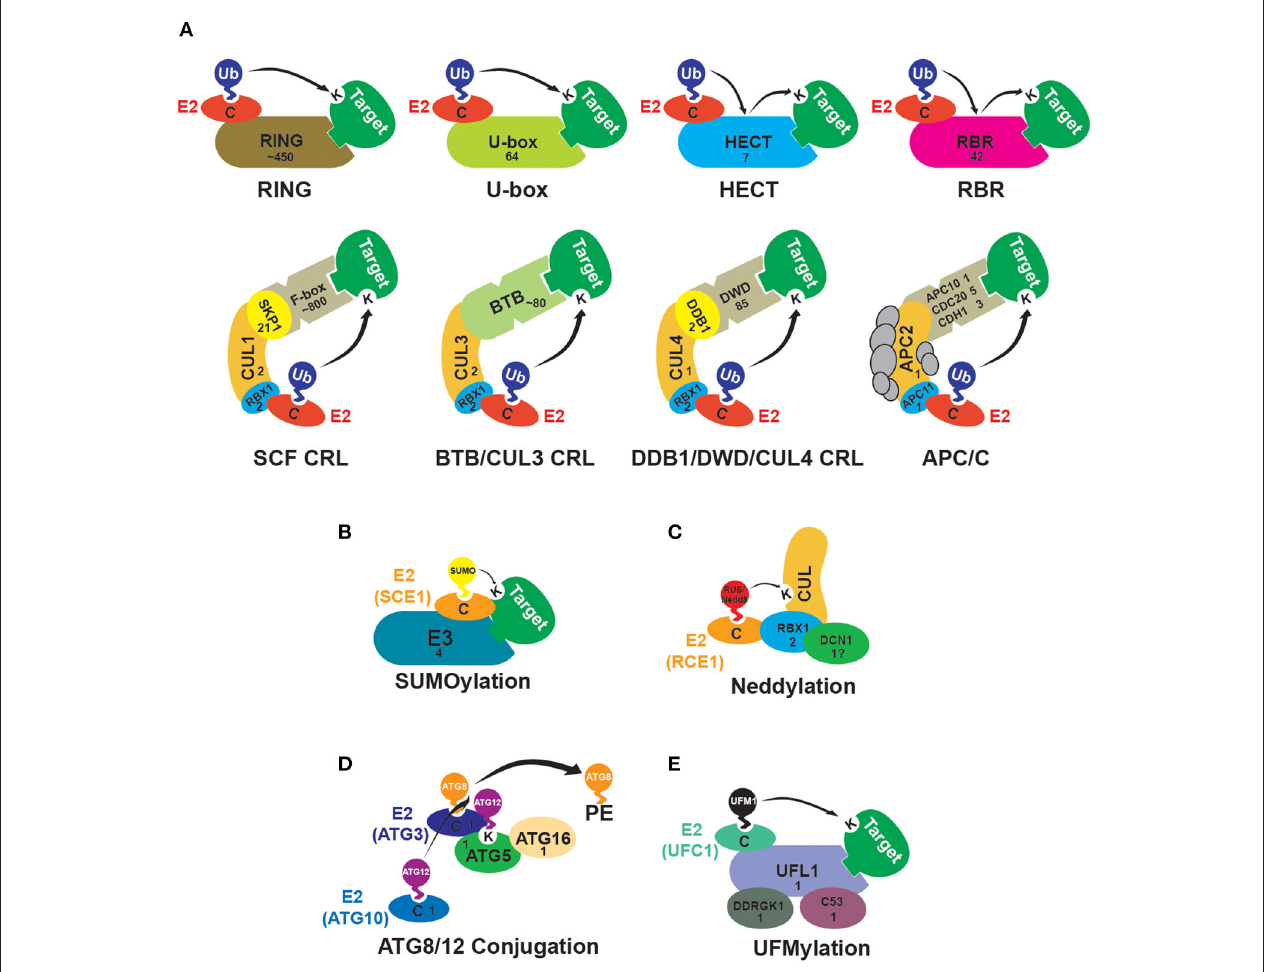
FIGURE 1 | Subunit composition of E3-ligases in plants. The numbers displayed within each subunit indicate the number of genes in the Arabidopsis thaliana genome putatively encoding the E3 ligase or E3 ligase component. (A) Schematics of E3 ubiquitin (Ub)-ligases in plants. RING ( R eally- I nteresting N ew G ene) and U-box E3 ligases bind an E2 and the target and facilitate direct transfer of Ub to the target protein. HECT ( H omologous to the E 6AP C arboxyl T erminus) and RBR ( R ING-in- B etween- R ING) E3 ligases transfer the Ub from the E2 to a cysteine residue in the E3, then from the cysteine to the target protein. The CRLs ( C ullin- R ING L igases) are multi-subunit structures with a Cullin (CUL) backbone protein that binds the E2 and a target adapter protein/complex. In SCF ( S kp1/ C UL1/ F -box) complexes target adaptor F-box proteins bind to an Skp1 ( S -phase K inase-associated P rotein 1)-like protein which interacts with CUL1. In the CRL3 complexes, a BTB ( B road-Complex, T ramtrack, and B ric-à-Brac) domain-containing protein binds to the target and CUL3. In the CRL4 complexes, WD40 domain-containing DWD ( D DB1 Binding WD 40) proteins bind the targets and interact with CUL4 through a DDB1 ( D amaged D NA B inding 1) protein bridge. The APC/C ( A naphase- P romoting C omplex/ C yclosome) contains at least 11 subunits. APC2 is a Cullin-like protein and APC11 is similar to RBX1 ( R ing B o x Protein 1). Target recognition occurs via the CDC20 ( C ell D ivision C ycle 20), CDH1 ( CD C20 H omolog 1), and APC10 subunits (Gray et al., 2002; Lechner et al., 2002; Schroeder et al., 2002; Capron et al., 2003; Downes et al., 2003; Gingerich et al., 2005; Stone et al., 2005; Kong et al., 2007; Lee et al., 2008; Lima et al., 2010; Marín, 2010; Trujillo, 2018; Saleme et al., 2021). (B) Schematic of the SUMO ( S mall U b-like Mo difier) E3-ligases. While SUMO E2s can directly interact with target proteins, the E3-ligases stimulate SUMO discharge by the E2 (Augustine and Vierstra, 2018) (https://www.frontiersin.org/articles/10.3389/fpls.2021.652170/full). (C) Proteins involved in the neddylation of Cullins. RBX1 functions synergistically with DCN1 ( D efective in C ullin N eddylation 1) to facilitate the transfer of RUB ( R elated to Ub iquitin)/Nedd8 from the E2 RCE1 ( R UB- C onjugating E nzyme 1) to Cullins. There are three possible homologs of DCN1 in Arabidopsis, though two lack the UBA ( Ub iquitin- A ssociated) domain seen in other DCN1 proteins (Merlet et al., 2009; Hosp et al., 2014). (D) Schematic of the ATG8 ( A u t opha g y-Related 8)/ATG12 conjugation pathway. The UBL ATG12 forms a thioester linkage with the E2 enzyme ATG10 and then is conjugated to ATG5. The UBL ATG8 is transferred to the E2 enzyme ATG3, then the ATG5-ATG12 conjugate, together with ATG16, acts as an E3 facilitating ATG8-phosphatidylethanolamine (PE) conjugation (Doelling et al., 2002; Bassham et al., 2006; Mizushima, 2020). (E) UFM1 ( U biquitin- F old M odifier 1) conjugation. UFL1 ( UF M1-Specific L igase 1) is the E3-ligase for UFM1 and catalyzes the UFMylation of multiple substrates. UFL1 ligase activity requires interaction with an adaptor protein called DDRGK1 ( DDRGK Domain-Containing Protein 1). Another UFL1 interactor, CDK5RAP3 ( CDK5 R egulatory Subunit- A ssociated P rotein 3), affects the UFMylation profile and may serve as a substrate adaptor. DDRGK1 and CDK5RAP3 homologs are present in Arabidopsis; the CDK5RAP3 homolog is called C53 (Daniel and Liebau, 2014; Stephani et al., 2021; Witting and Mulder, 2021).